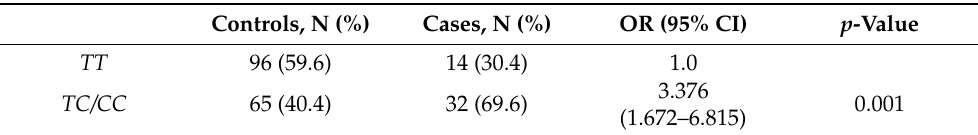
Table 6. Distribution of CYP19A1 codon 39 polymorphisms in women with POF and controls (fertile women).